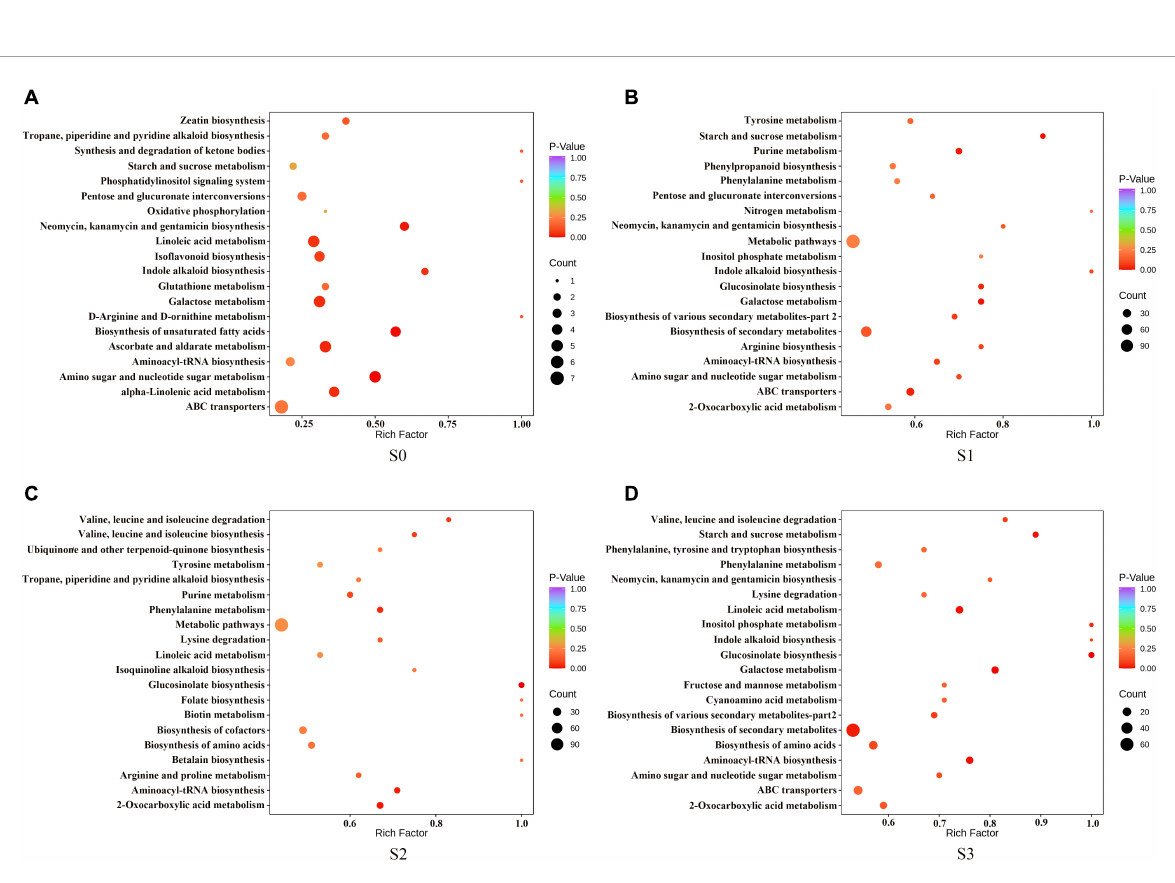
FIGURE6 Kyoto encyclopedia of genes and genomes (KEGG) enrichment pathway of different metabolites in fermented rapeseed cake. (A) KEGG enrichment pathway of different metabolites in fermented rapeseed cake in S0. (B) KEGG enrichment pathway of different metabolites in fermented rapeseed cake in S1. (C) KEGG enrichment pathway of different metabolites in fermented rapeseed cake in S2. (D) KEGG enrichment pathway of different metabolites in fermented rapeseed cake in